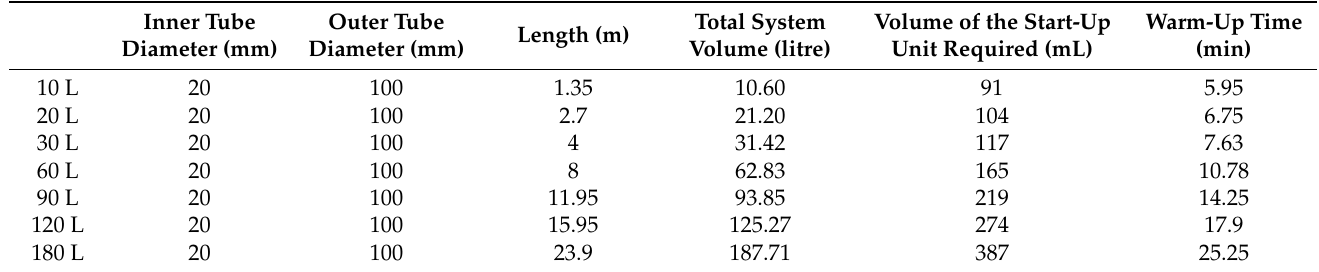
Table 4. Parameters of different reactors and the corresponding start-up